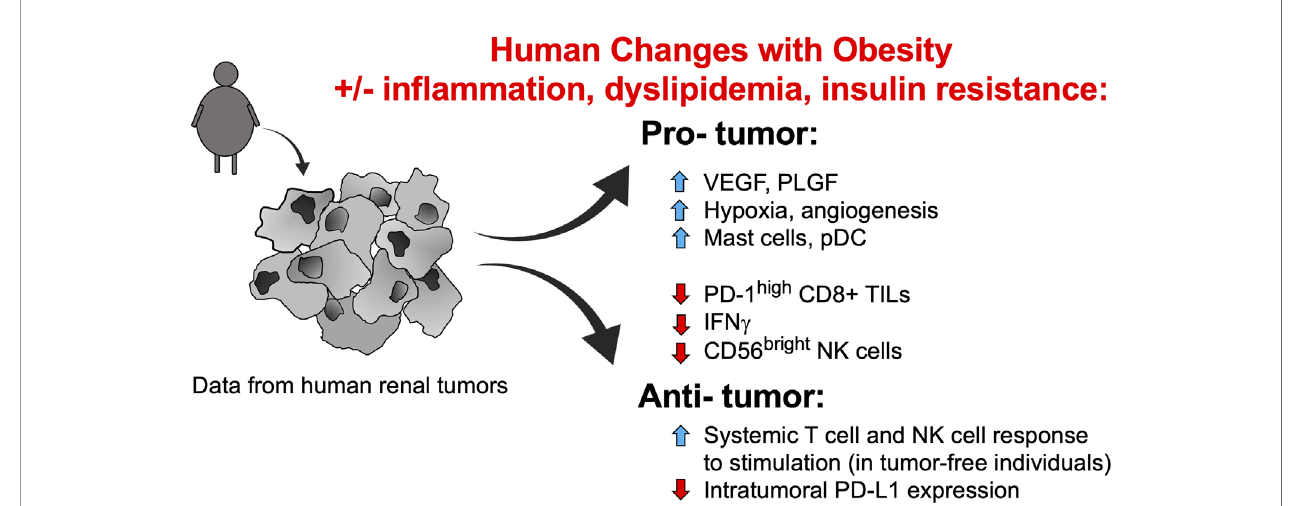
FIGURE 2 | Identi fi ed obesity-associated changes in humans that are predicted to facilitate renal tumor progression. Studies of tumor-free individuals and human renal tumors suggest that many obesity-associated changes to the immune compartment and soluble growth factors should favor tumor progression, although some alterations that would promote enhanced tumor clearance and/or ICI ef fi cacy have also been noted. Note that the contributions of obesity-associated factors such as in fl ammation, dyslipidemia, and insulin resistance remain unclear, in terms of their combined effects on immune function. NK, natural killer;